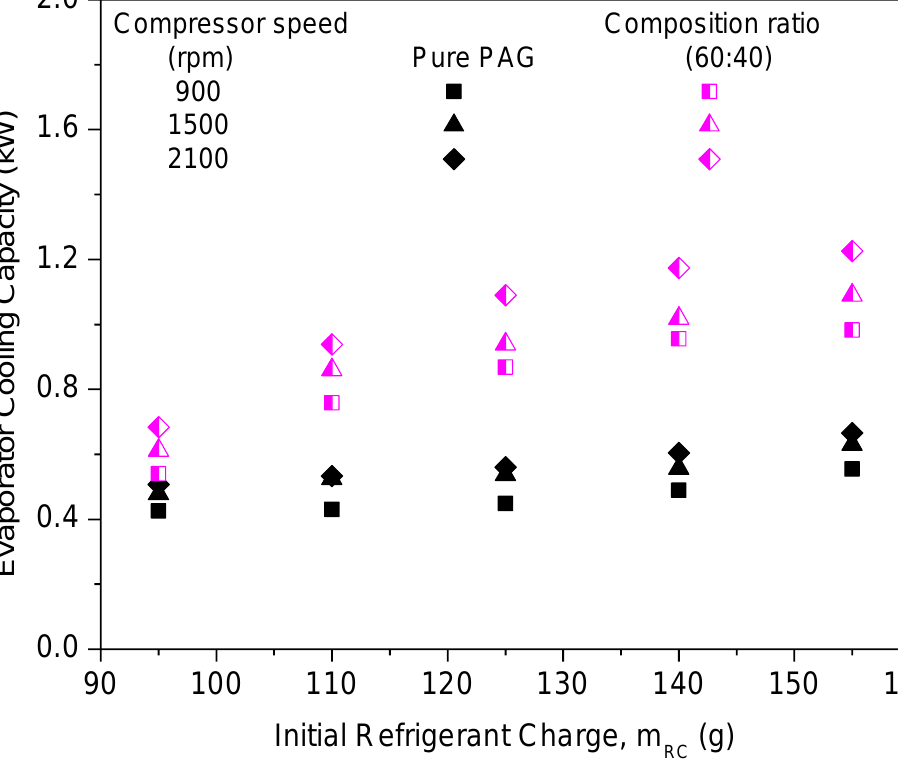
Figure 12. Cooling capacity of the hybrid nanolubricants at the optimum 60:40 composition